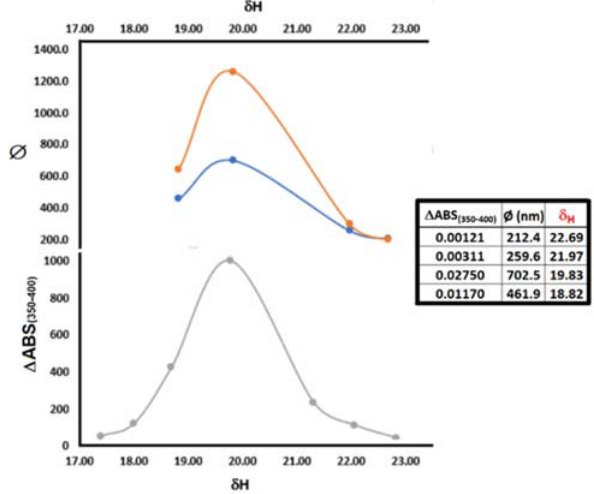
Figure 9. DLS profiles of R3 aggregates in solutions prepared from a THF/(buffer-pH 10.0 ) mixture: variation of Ø (blue) related to the ∆ ABS 350–400 changes at the same δ H range (gray); variation of Ø (orange) after one hour.